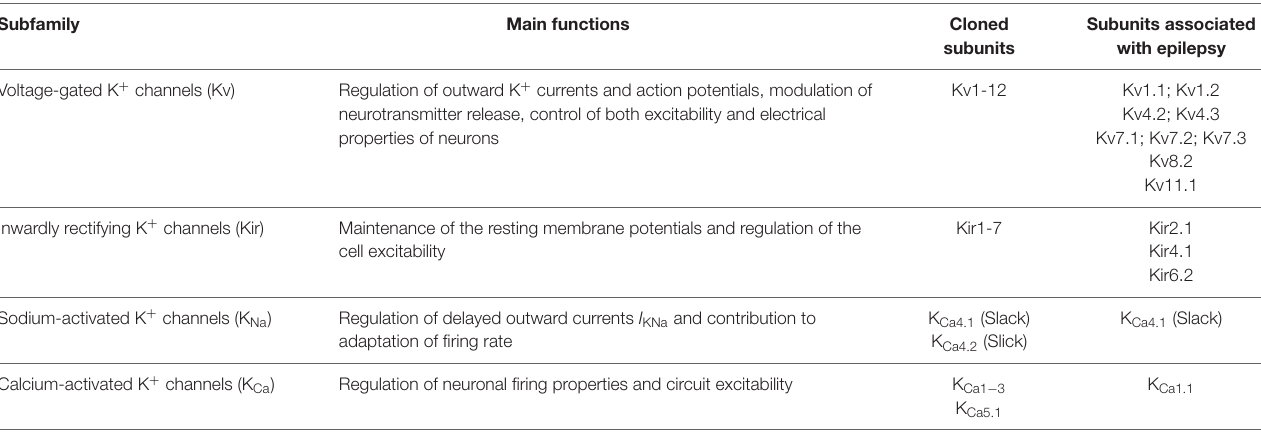
TABLE 1 | Summary of human K + channels subfamilies involved in epilepsies.